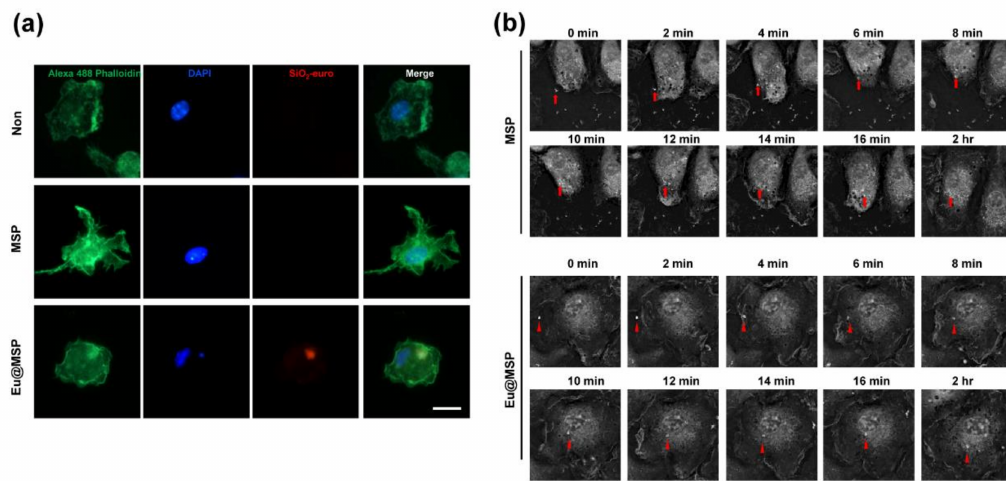
Figure 7. MSP and Eu@MSP uptake by mouse bone marrow-derived macrophages (BMDMs). ( a ) Intracellular staining of europium red-coupled mSiO 2 in BMDMs (Scale bar = 5 µ m). BMDMs were incubated with 10 µ g/mL of MSP and Eu@MSP for 4 h. The cortical F-actin and nucleus were stained using Rhodamine Texas Red and DAPI, respectively. ( b ) MSP and Eu@MSP uptake observation of BMDMs by live cell holotomography. BMDMs were incubated with 10 µ g/mL of MSP and Eu@MSP for 4 h under live cell holotomography. White triangles indicate MSP particles. Red triangles indicated Eu@MSP.